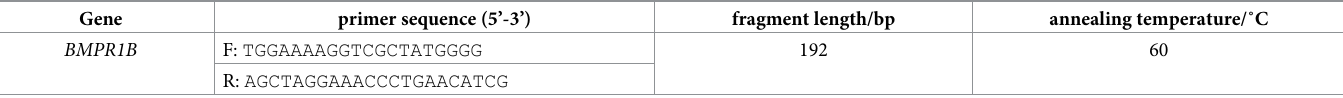
Table 1. Primer information of BMPRIB Gene. Gene